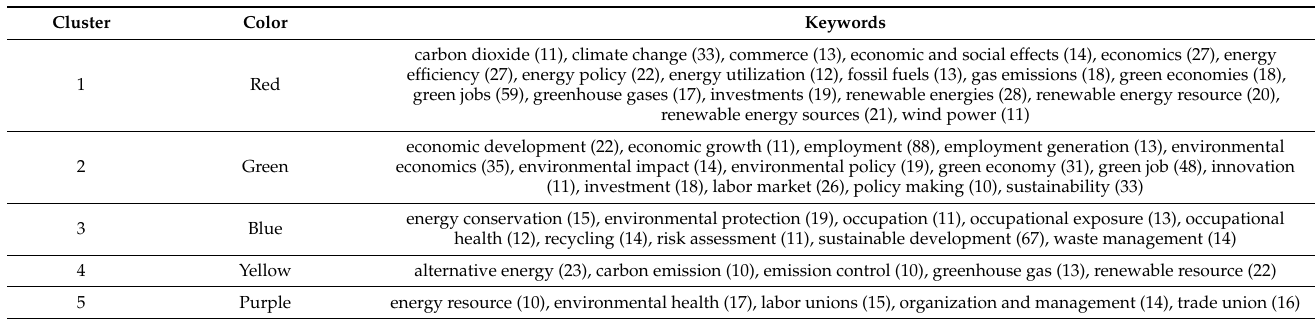
Table 4. Clusters of keywords co-occurrences visible in Figure 4 for Scopus Q5